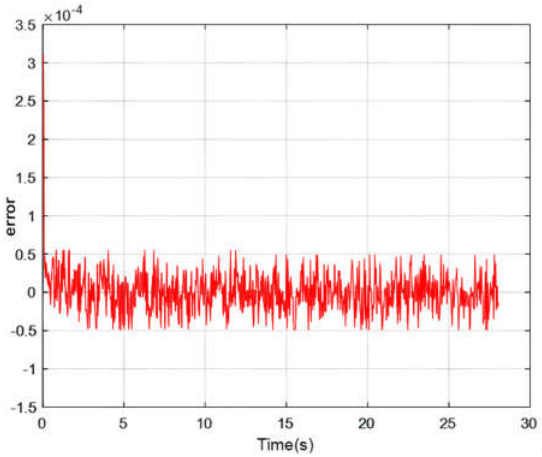
Figure 6. Error curve between test output and expected output of low-pressure spool speed under GWO-EBPNN.